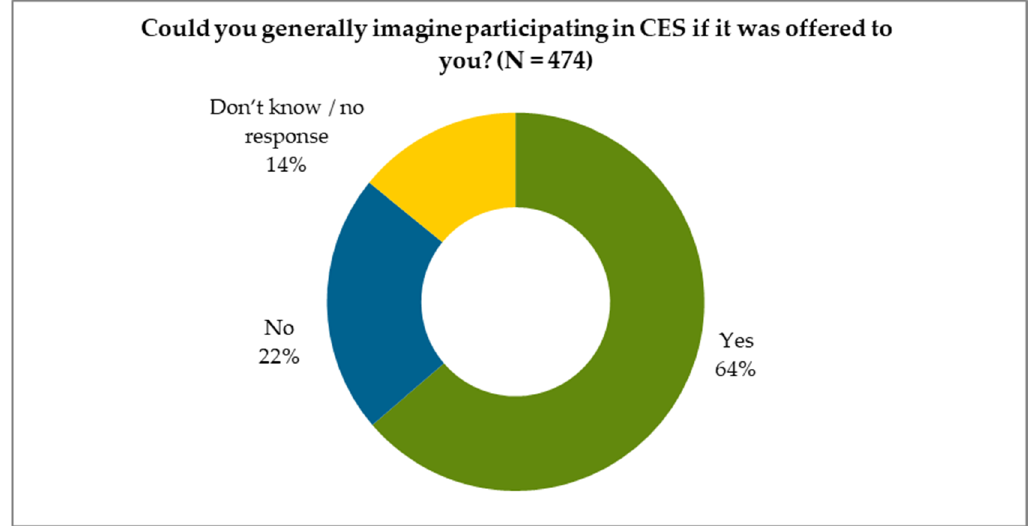
Figure 3. Assessment of willingness to participate in a CES project.